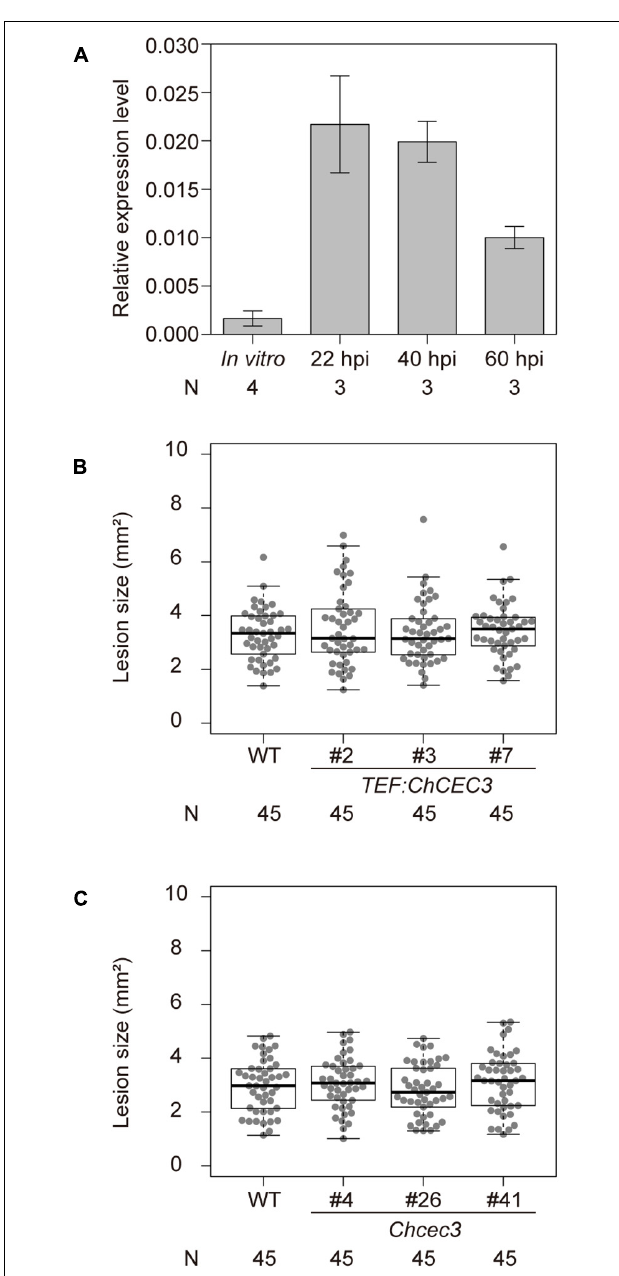
FIGURE 5 | (A) RT-qPCR analysis of ChCEC3 transcript levels in hyphae in vitro versus in planta infection time course. 22, 40, and 60 h post inoculation (hpi) correspond to the pre-penetration stage, the early biotrophic stage, and the transition to necrotrophic stage, respectively. ChCEC3 transcript levels were normalized against ChTubulin . Data represent the means of biological replicates. Error bars indicate standard error of the mean. N represents the number of biological replicates. (B,C) Boxplots of lesion area assays using ChCEC3 overexpressors and knock-out mutants. For lesion area assays, A. thaliana ecotype Col-0 was inoculated with C. higginsianum strains. Symptoms were observed 6 days after inoculation. Data represent the medians of biological replicates. N represents the number of biological replicates. Analysis of variance with Tukey post hoc honestly significant difference test ( P < 0.05) was performed. The experiments were repeated three times with similar